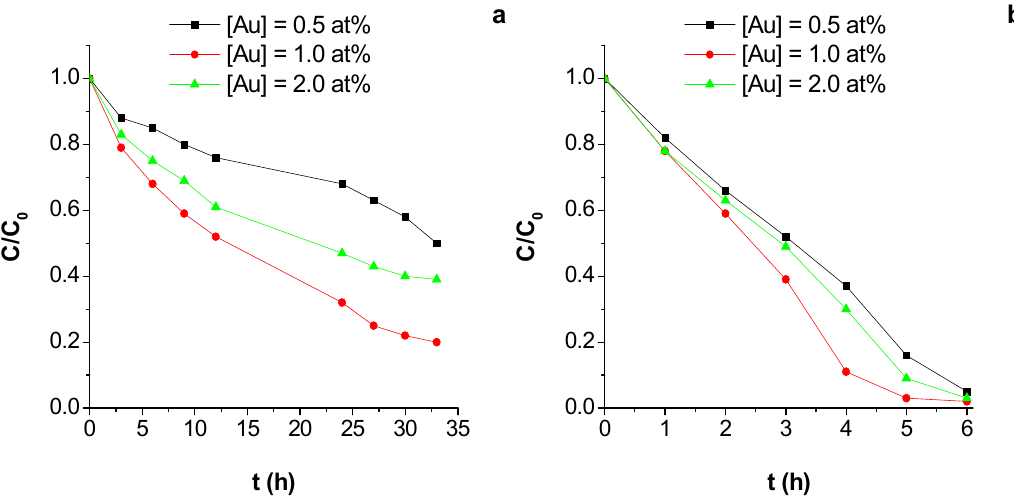
Figure 5. C/C o ratio during AO7 degradation by CWPO (a) and assisted with visible radiation (b) Figure 5. C / C o ratio during AO7 degradation by CWPO ( a ) and assisted with visible radiation ( b ) processes at different gold loadings ([AO7] = 35 mg/L, [H 2 O 2 ] = 20 mM and [Au/CeO 2 ] = 0.5 g/L). processes at di ff erent gold loadings ([AO7] = 35 mg / L, [H 2 O 2 ] = 20 mM and [Au / CeO 2 ] = 0.5 g / L). Adapted from Ge et al. [106]. Adapted from Ge et al. [106].